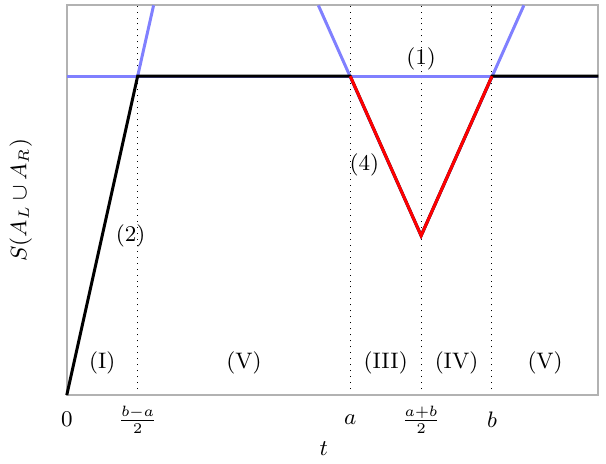
Figure 8 . Evolution of entropy for two small intervals 3 a > b with a = 7 and b = 8 shown. The numbers (1), etc., refer to the channels that contribute. The system appears to equilibrate, however, there is a later dip in the entropy corresponding to the island saddle in the BH